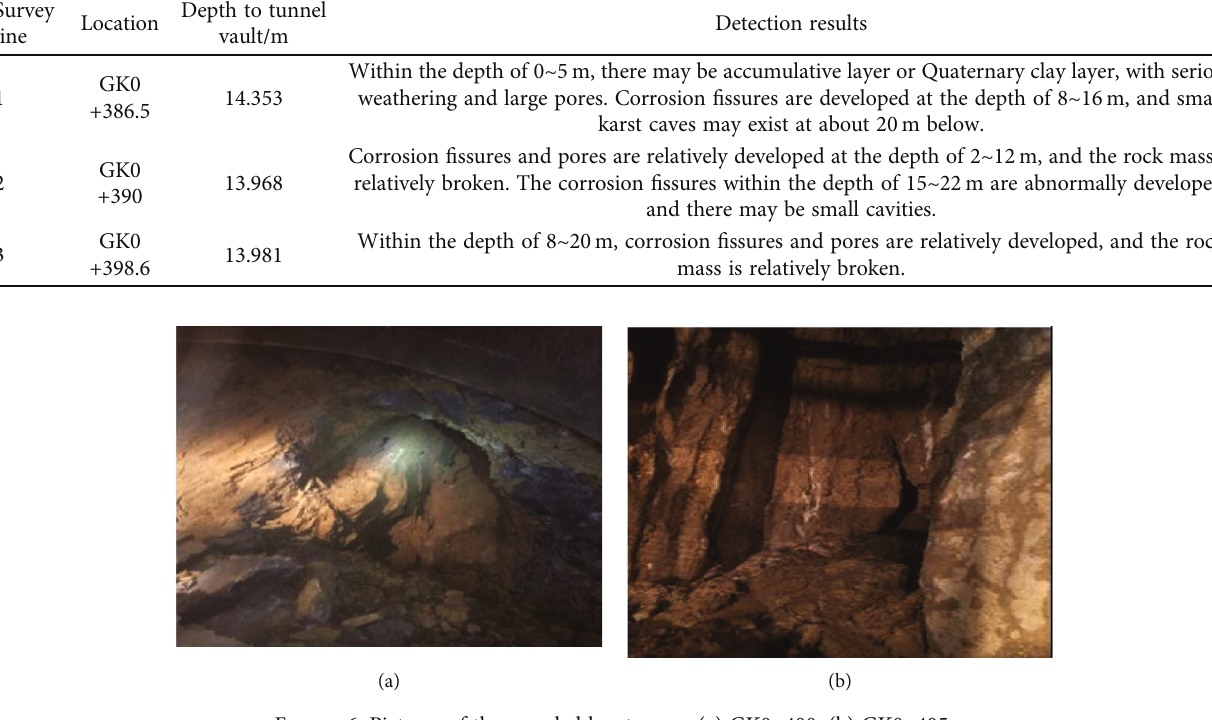
Table 1: Surface detection result of